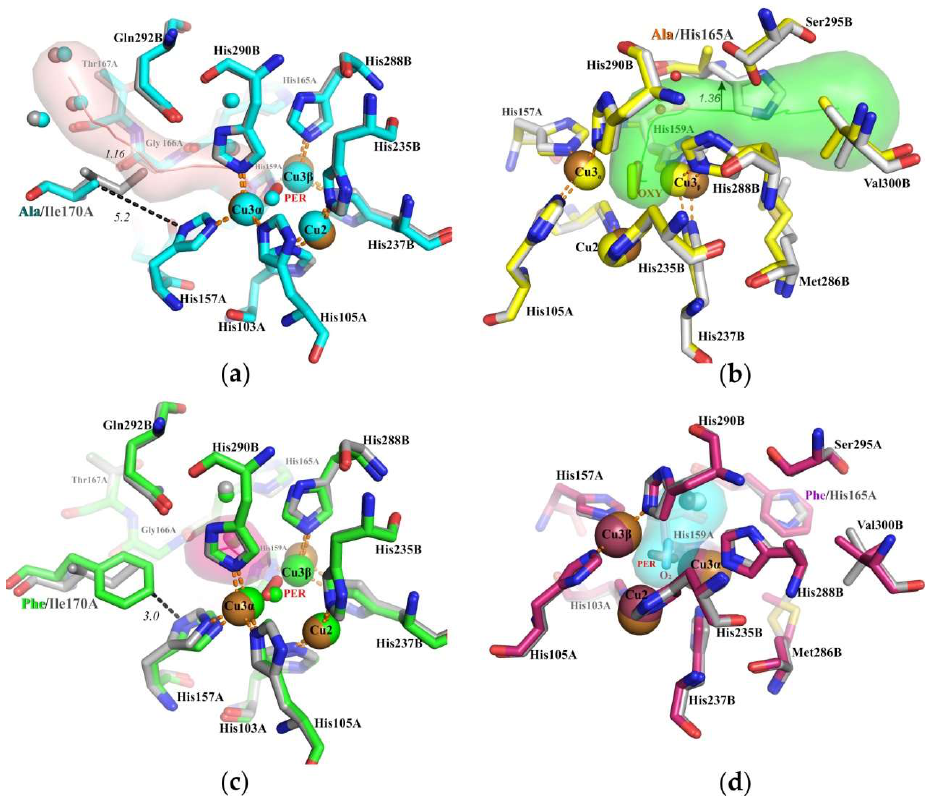
Figure 2. Structure of the T2 / T3 center of SgfSL Ile170Ala variant ( a ), His165Ala ( b ), Ile170Phe ( c ) and His165Phe ( d ). PER - peroxide ion, OXY - dioxigen. Copper ions are shown as spheres. The distances between atoms are in angstroms. Residues of the wild type protein are shown in gray, residues of mutant proteins are shown in various colors. The trajectories of tunnels are shown as colored semi-transparent shapes.